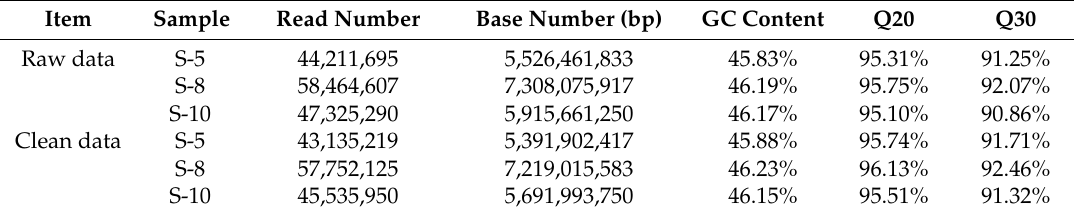
Table 2. Summary of transcriptomes from leaf in A. megalophylla